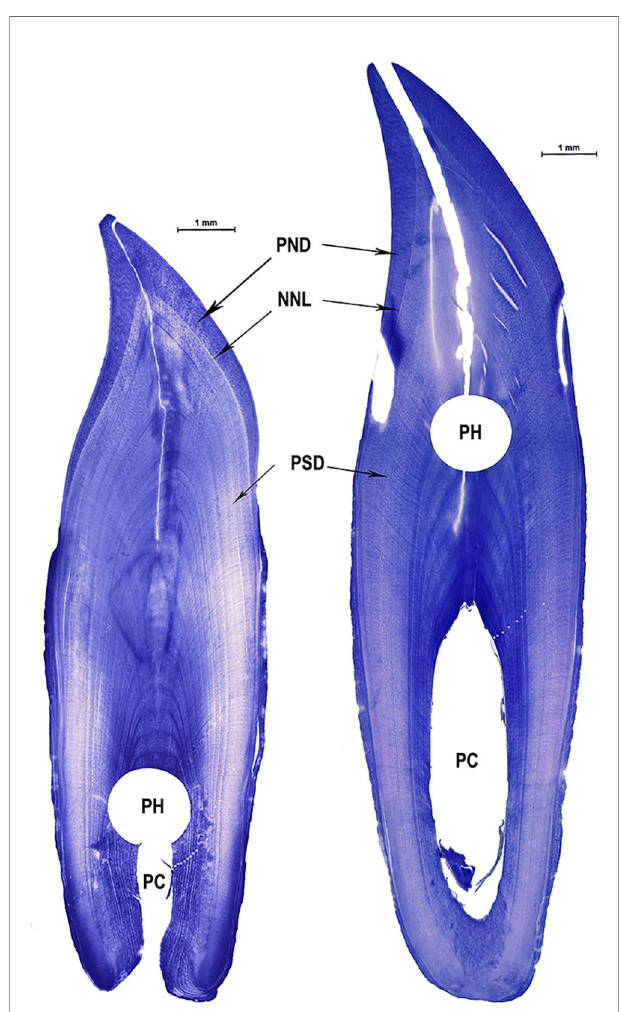
FIGURE 3 | Thin sections from two Sotalia sp. teeth collected from handicrafts (left: tooth N1-10 with TL= 13.16 mm; right: tooth B2-5 with TL=17.4 mm). PND, Prenatal dentine, NNL, Neonatal line; PSD, Postnatal dentine; PC, Pulp cavity; PH, Holes made for craft construction. White dots indicate the GLGs counts in the dentine corresponding to the